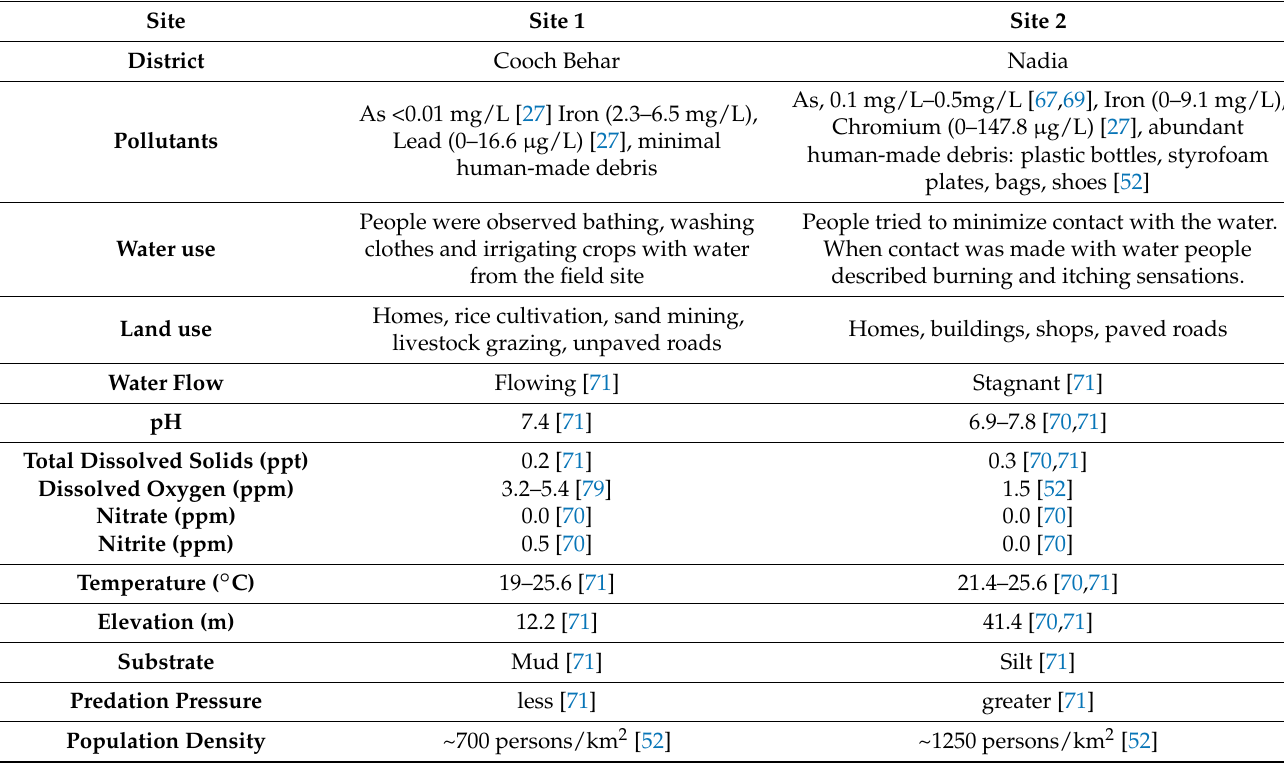
Table 1. Description of conditions at both field